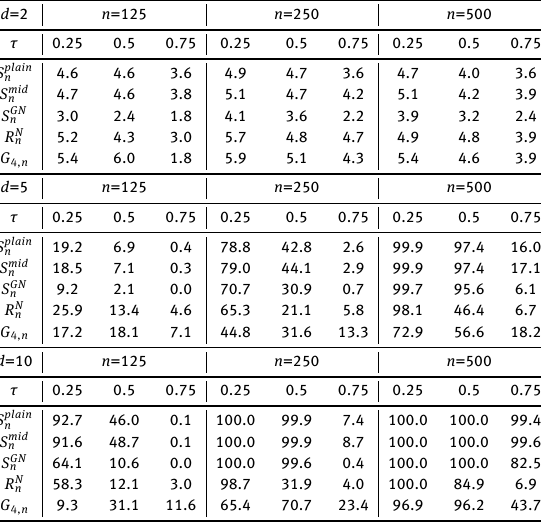
. Power deteriorates n